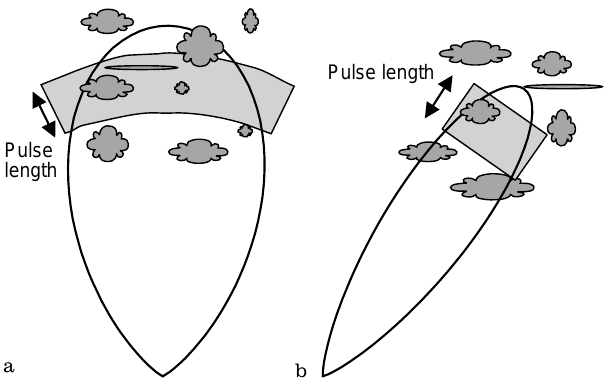
Fig. 6a, b. Schematic representations of the typical distribution of scattering centers in the atmosphere. The spatial intermittency within the beams are